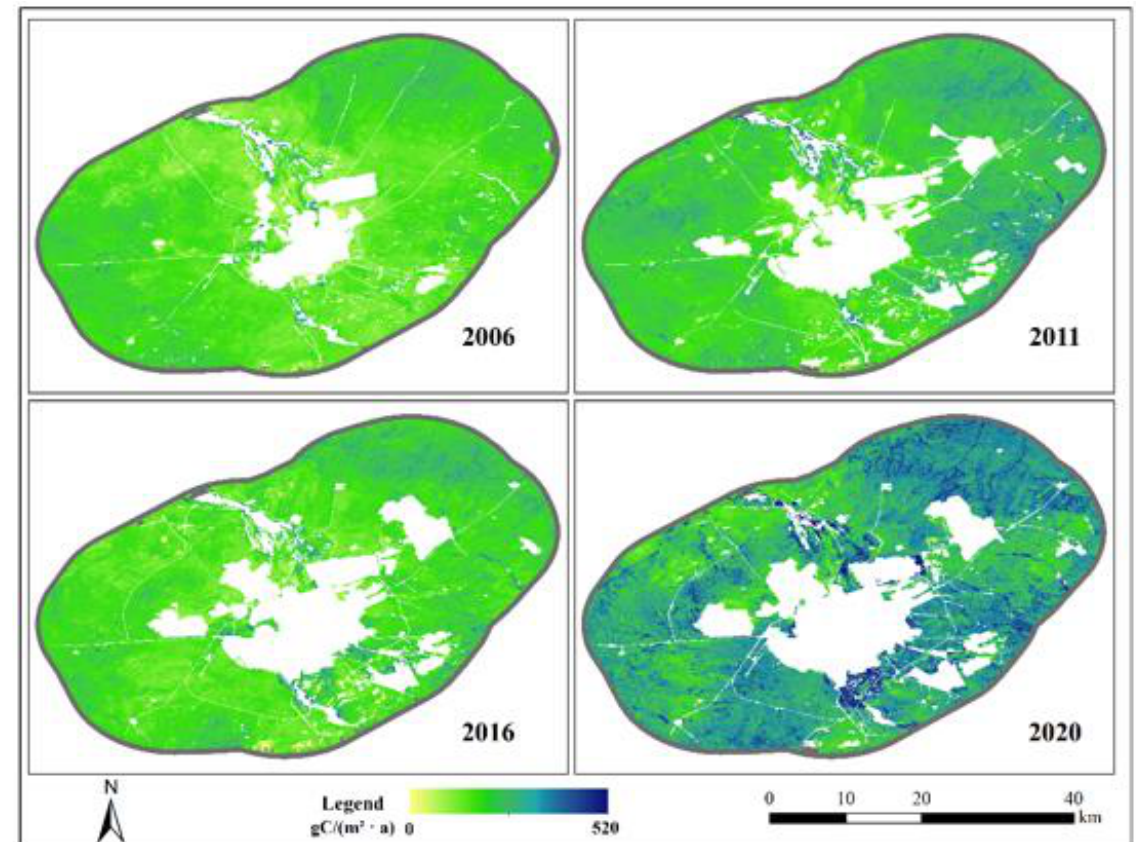
Figure 5. Distribution of the actual NPP in the experimental years.